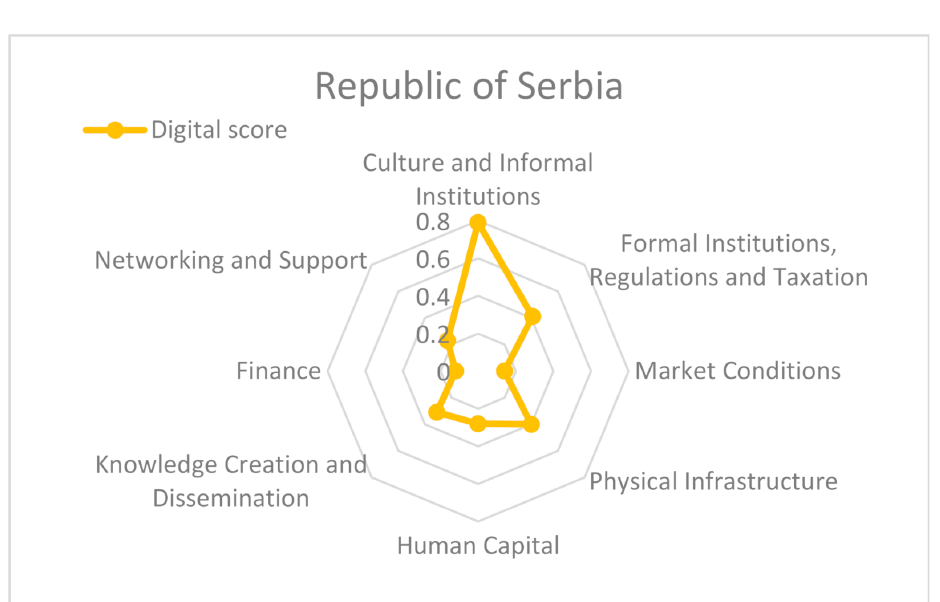
Figure 1. Values of pillars in the digital entrepreneurial system of the Republic of Serbia, in their digital